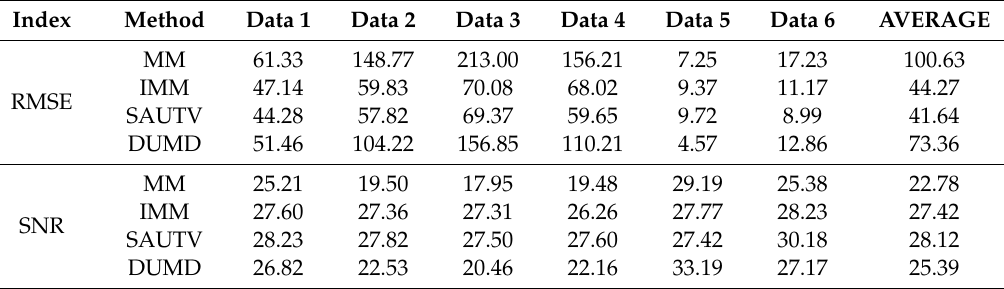
Table 2. Evaluation parameters.